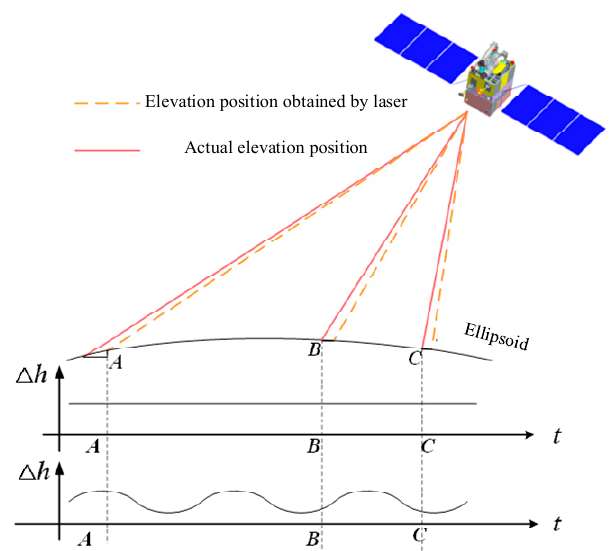
Figure 4. Schematic diagram of satellite platform microvibration detection based on laser altimeter.